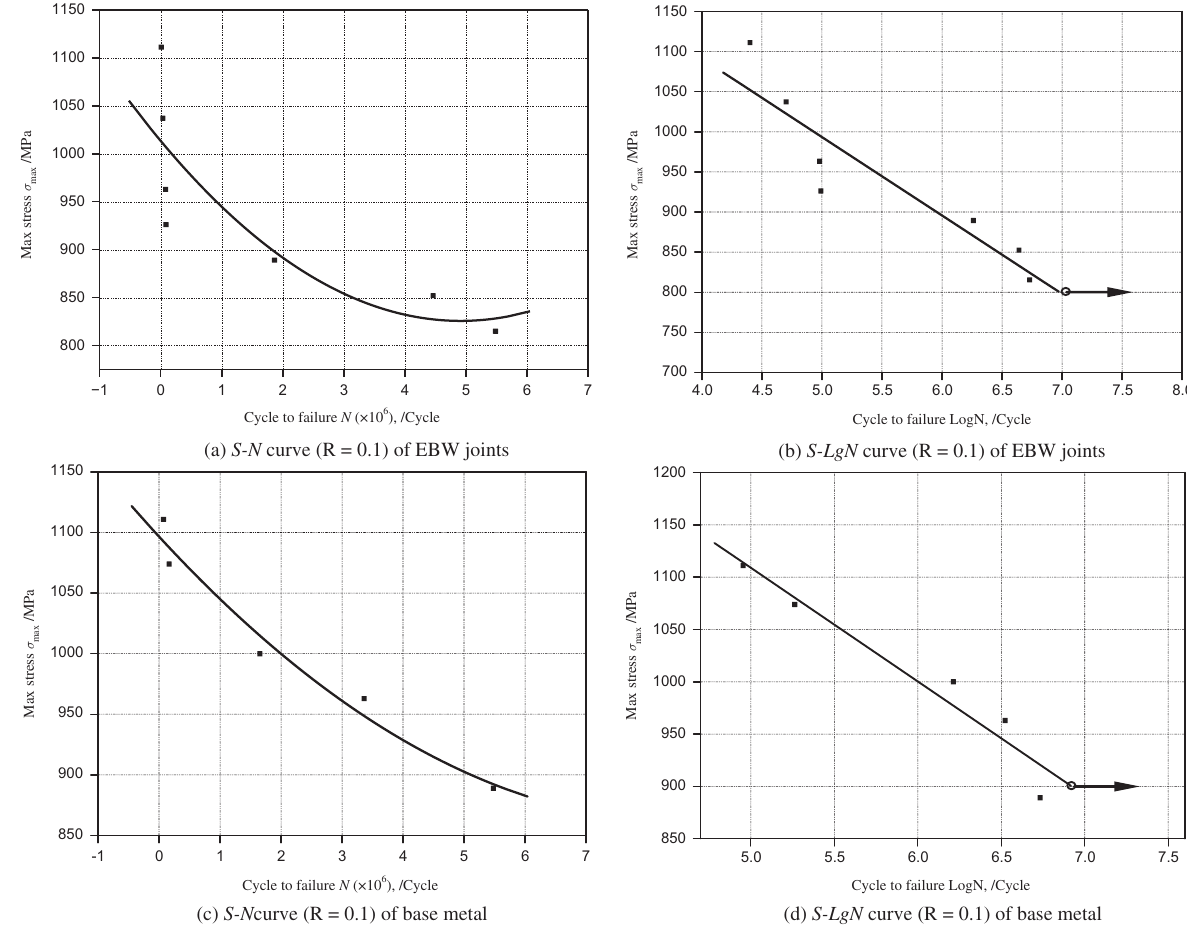
Figure 5: S – N and S – LgN curves ( R ¼ 0.1) of four-point bend test of EBW joint for TA15 titanium alloys.